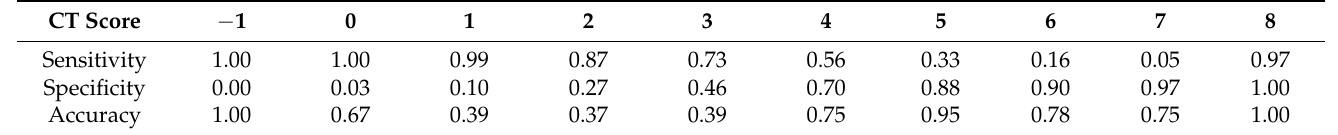
Table 7. Sensitivity, specificity, and accuracy of CT scores for diagnosing SPNs.